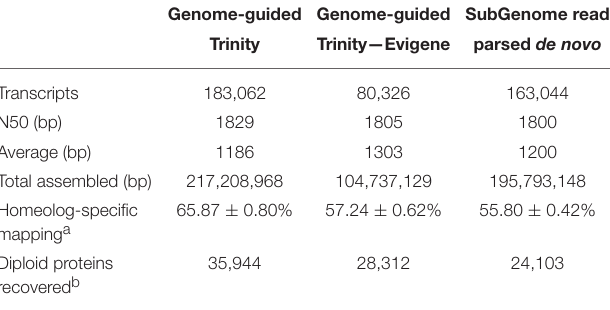
TABLE 1 | Assembly stats of genome-guided Trinity assembly, genome-guided assembly filtered with Evigene, and read parsed de novo